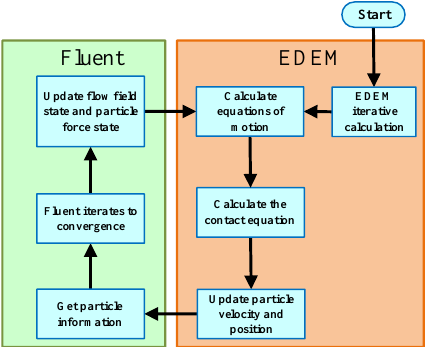
Figure 12. Fluent – EDEM coupling calculation process. Figure 12. Fluent–EDEM coupling calculation